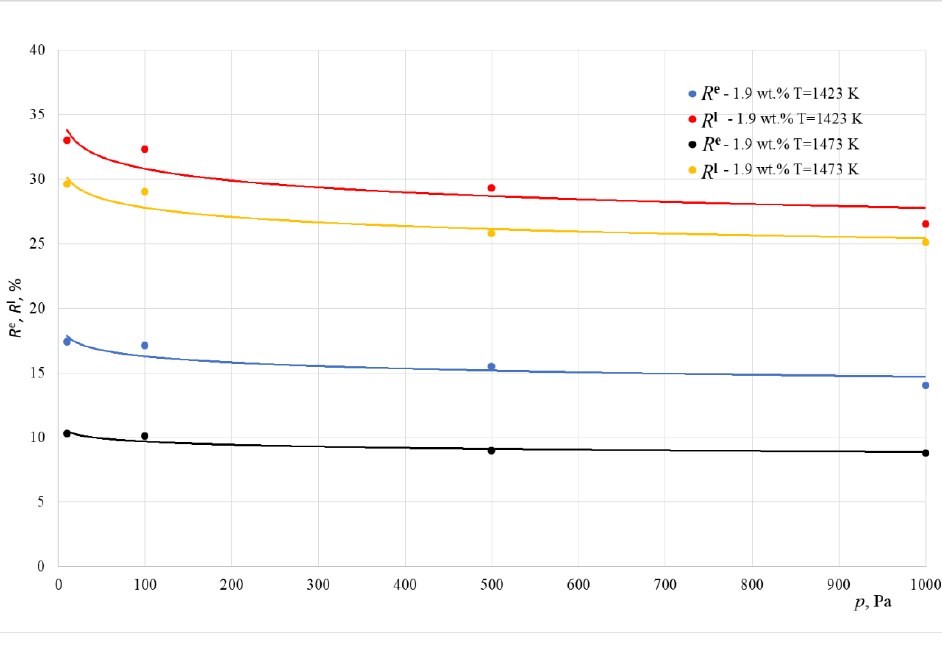
Figure 7. The share of the R e and R l resistance in the overall resistance of the evaporation process (CCF).